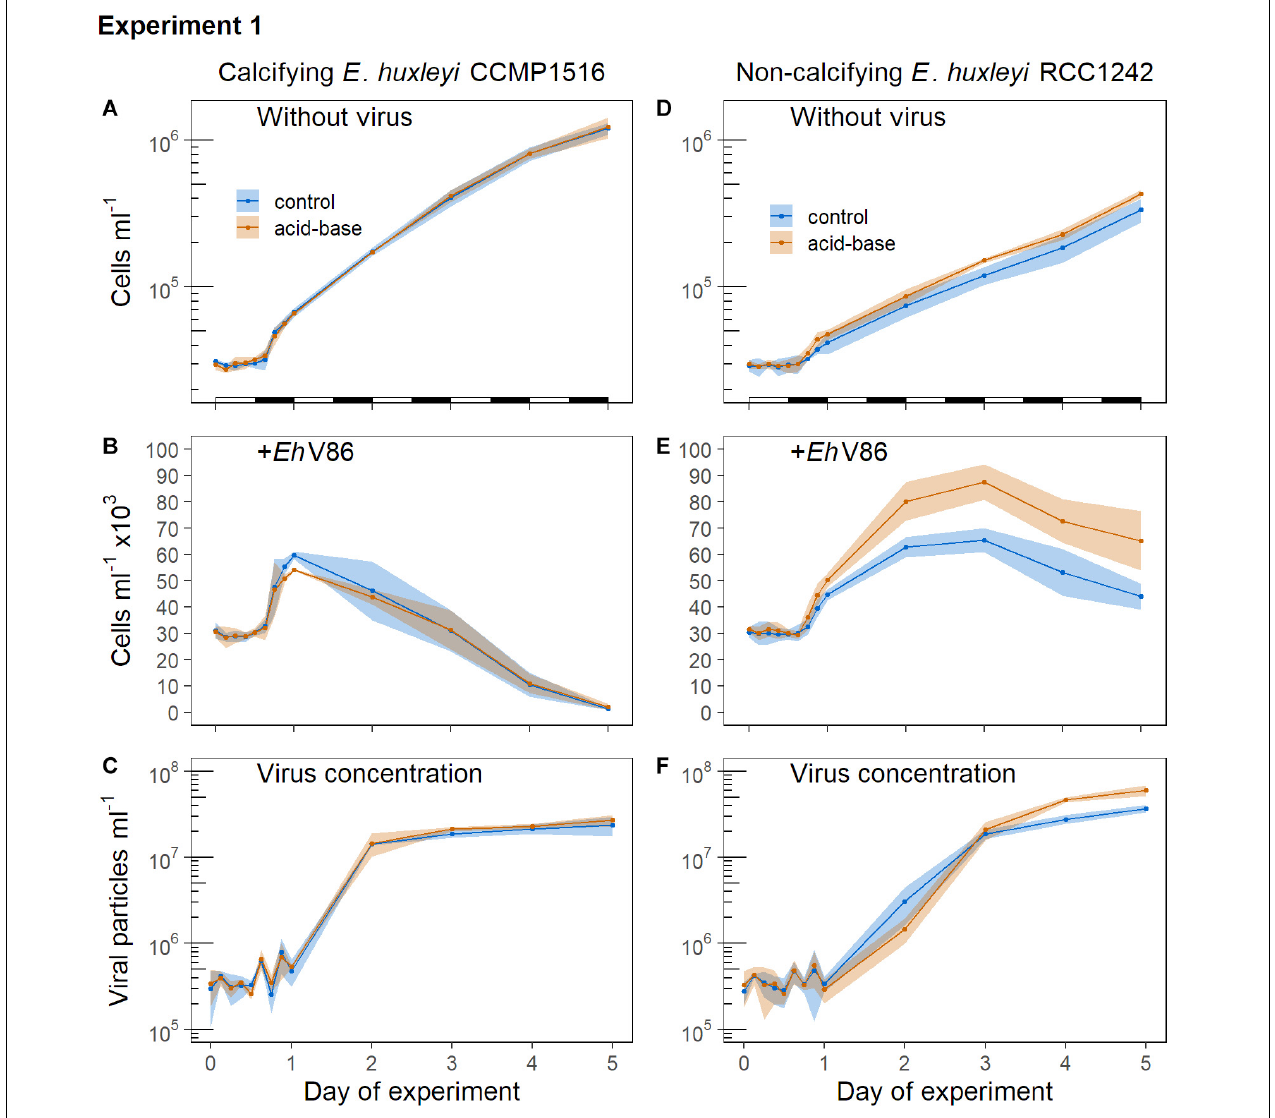
FIGURE 2 | Addition of virus to normal cells of E. huxleyi (controls = blue symbols) and to cells treated with acid and base (red symbols). Virus was added at the beginning of the light period (12:12 h light-dark cycle). Symbols represent the sample means and ribbons illustrate the 95% CI of the sample mean ( n = 3). The acid-base treatment was conducted at the end of the dark phase before virus addition. (A) Concentration of calcifying E. huxleyi CCMP1516 without virus; (B) cell concentration when virus was added; (C) concentration of viral particles. (D) Concentrations of non-calcifying E. huxleyi RCC1242 without virus and (E) when virus was added; (F) concentration of viral particles. Light-dark cycle is indicated in (A,D)